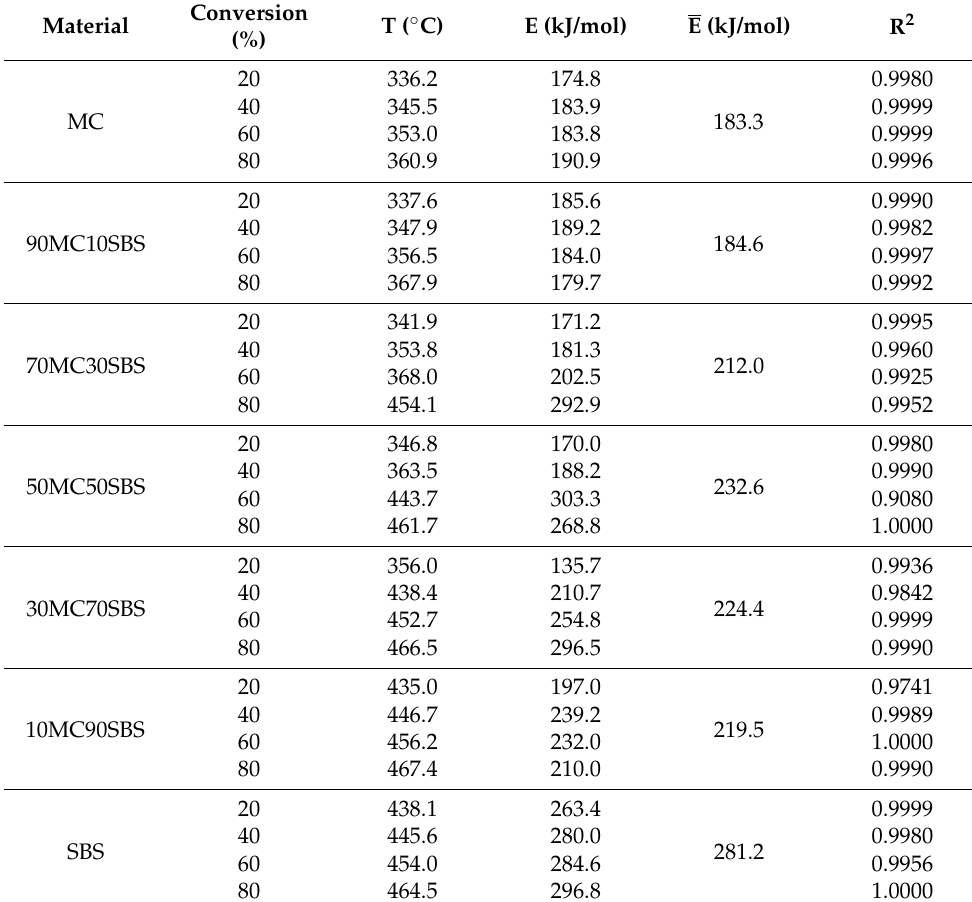
Table 2. Kinetics parameters of samples with different mixing